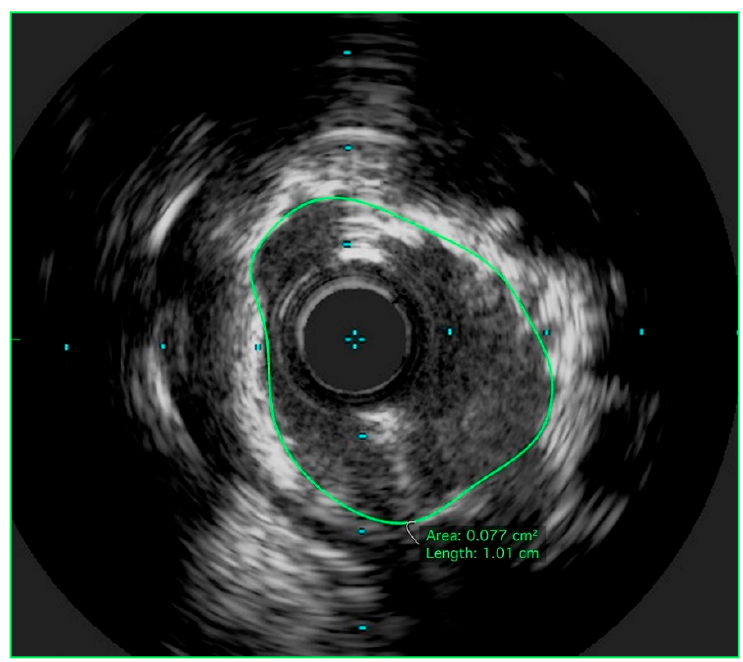
Figure 2. Post-orbital atherectomy IVUS of LMCA. IVUS of the LMCA with a 40 MHz imaging catheter performed after orbital atherectomy revealing 270 degrees of calcium and a minimal luminal area of 7.7 mm 2 . IVUS: Intravascular ultrasound; LMCA: Left main coronary artery.